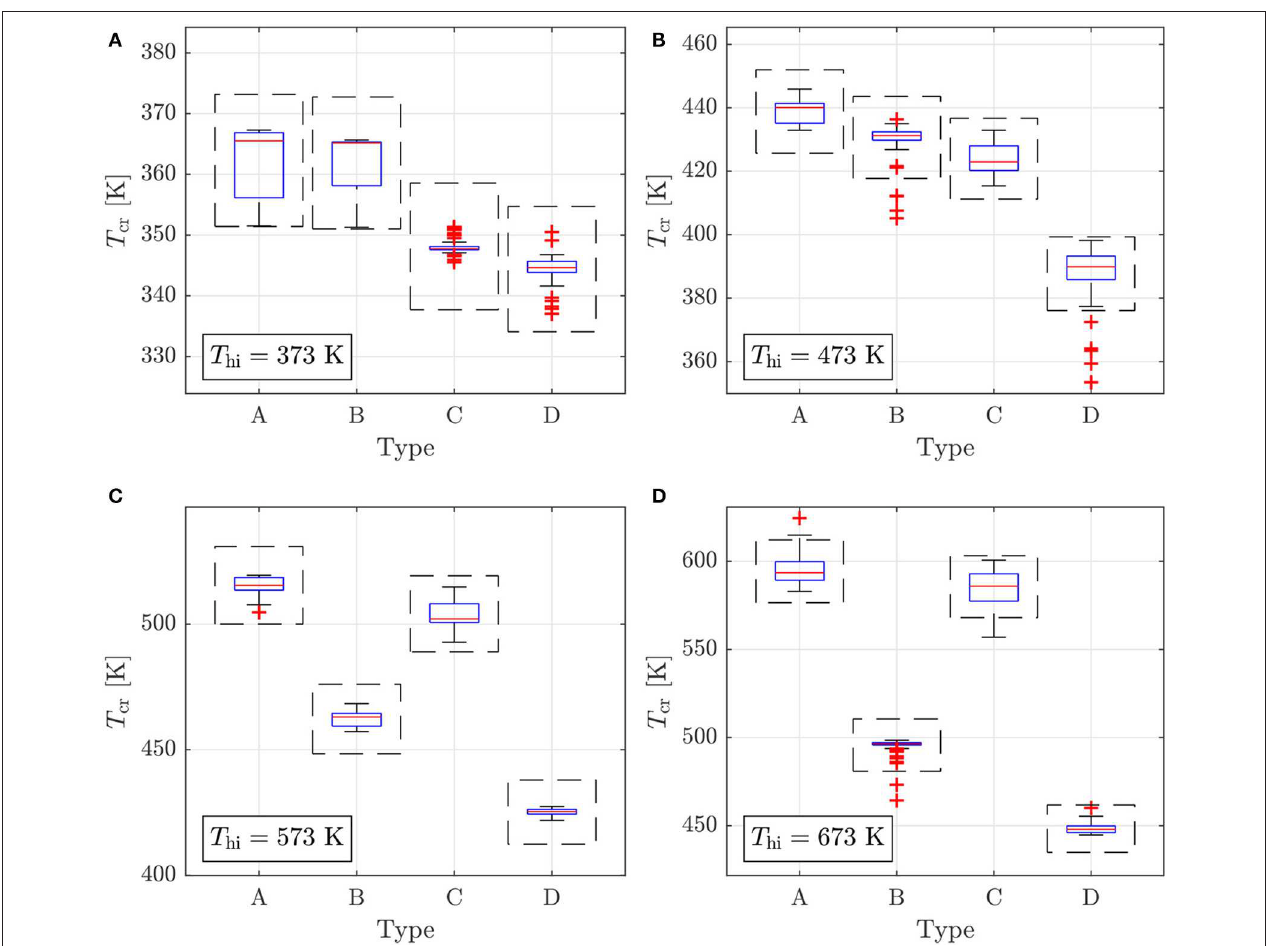
FIGURE 11 | Box plots for the optimal critical temperatures T cr that lie on the Pareto front for each optimization type ( A : subcritical, η = 0.85; B : transcritical, η = 0.85; C : subcritical η = var.; D : transcritical η = var.). The black-dashed lines correspond to ± 3% of the mean critical temperature, whilst the red crosses represent the outliers of the